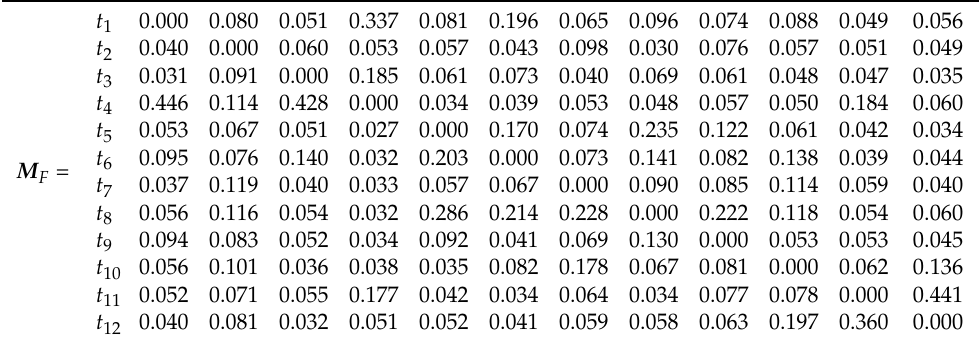
Table 3. Feature Importance Matrix M F